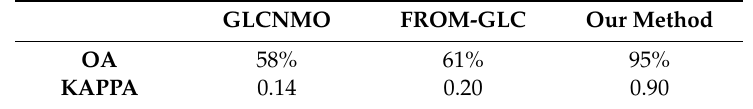
Table 7. Accuracy assessment of the Global Map–Global LC (GLCNMO) and Finer Resolution Observation and Monitoring Global LC datasets (FROM-GLC) and our method.